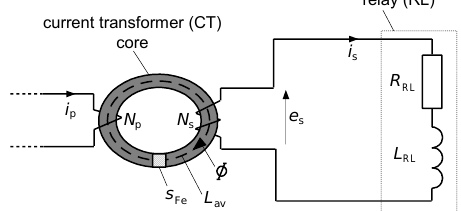
Figure 14. The RCD simplified model for the theoretical analysis. N p , N s — the number of turns of the primary and secondary windings of the CT, respectively, L av — average length of the magnetic flux path in the iron core of the CT, s Fe — cross-section of the core of the CT, e s — induced secondary voltage in the CT, i p — primary current of the CT, i s — secondary current of the CT, Φ — magnetic flux in the iron core of the CT, L RL , R RL — parameters (inductance and resistance, respectively) of the relay. The RCD operates if the secondary current i s has a high enough value to trigger the relay RL. However, this secondary current strictly depends on the secondary voltage e